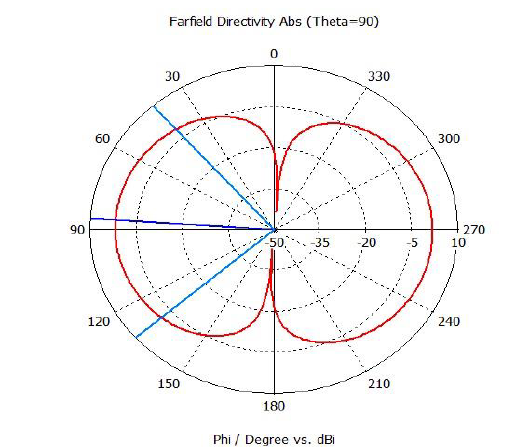
Fig.5. VSWR Vs Frequency /GHz of proposed RFID TAG.